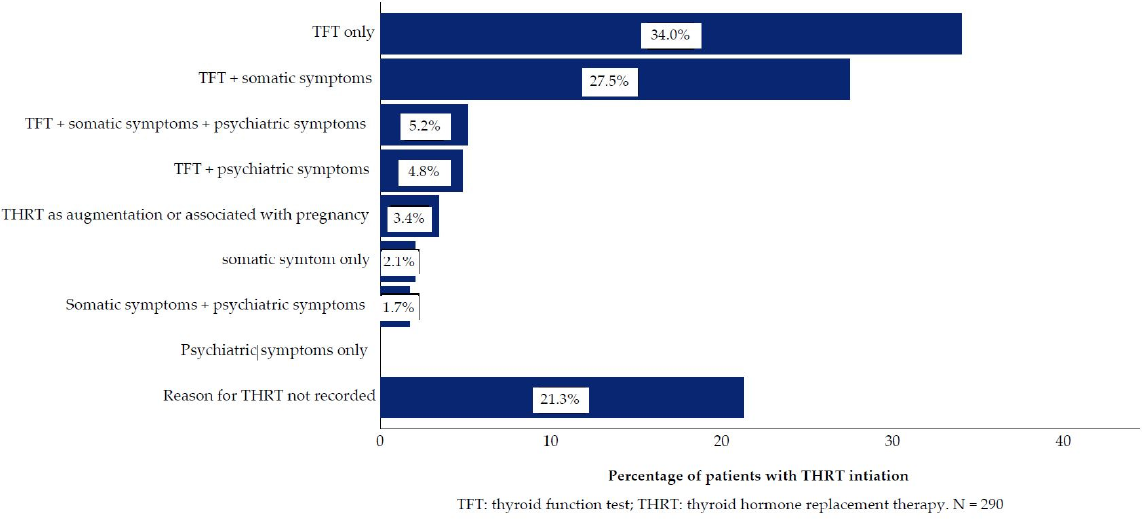
Figure 2. Decision drivers for Thyroid Hormone Replacement Therapy